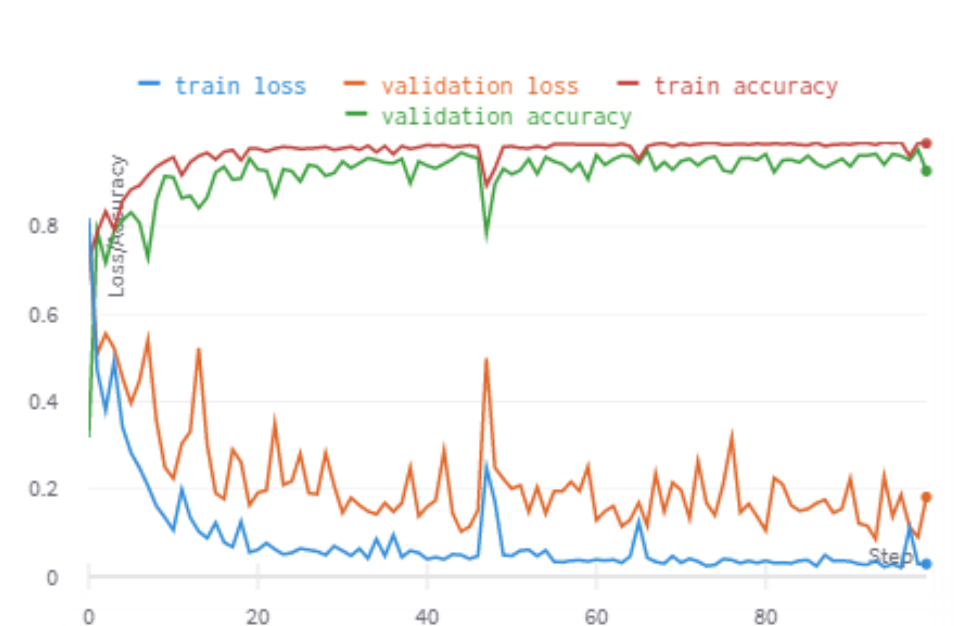
Figure 6. Training loss and accuracy using the data omitting batch 5, and validation loss and accuracy from the dataset containing only batch 5. Note that the loss is expectedly slightly higher for the validation dataset but nonetheless shows that the loss decreases and stabilises, indicating that the model has learned to extract generalisable features. Generated using “Weights and Biases” integration